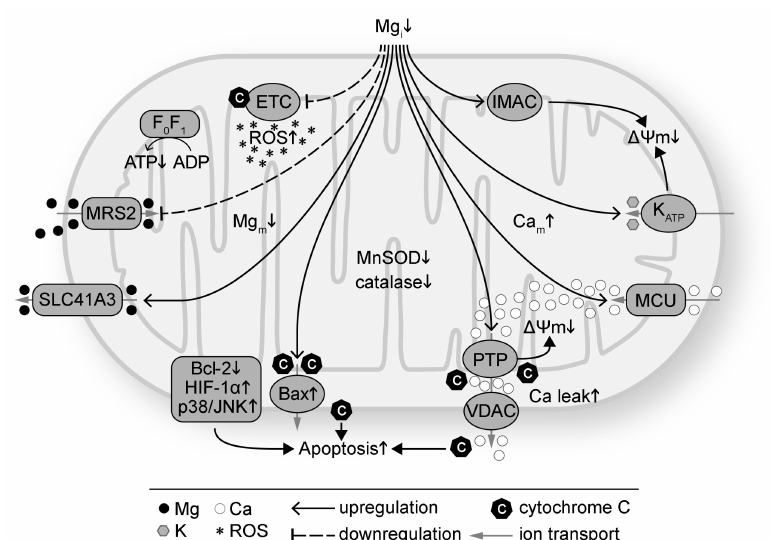
Figure 1. Intracellular magnesium (Mg) deficiency (Mg i ↓ ) induces mitochondrial oxidative stress and dysfunction. Mg deficiency downregulates the electron transport chain (ETC) and increases reactive oxygen species (ROS) production. Mg deficiency also suppresses the antioxidant defense system with decreased protein levels such as manganese SOD (MnSOD) and catalase. Mg deficiency downregulates ATP synthase (F0F1) and decreases ATP production. Intracellular Mg deficiency inhibits Mg transport into mitochondria via mitochondrial RNA splicing 2 protein (MRS2) and promotes mitochondrial Mg (Mg m ) e ffl ux via SLC41A3. Mg deficiency promotes apoptosis by increasing cytochrome C release via Bax and voltage dependent anion channel (VDAC), decreasing anti-apoptotic proteins such as the Bcl-2 family, and increasing pro-apoptotic proteins such as HIF-1 α and p38 / JNK. Mg deficiency induces mitochondrial membrane ( ∆Ψ m ) depolarization by increasing the permeability of mitochondrial permeability transition pore (PTP), ATP-sensitive K channel (K ATP ), and inner membrane anion channel (IMAC). Mg deficiency increases mitochondrial Ca (Ca m ) via the mitochondrial Ca uniporter (MCU). Ca leak from mitochondria via VDAC is also increased with Mg